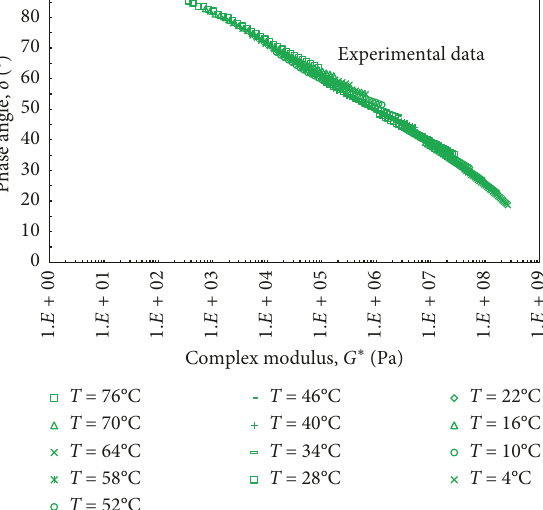
40 ° C, depending on the ÷